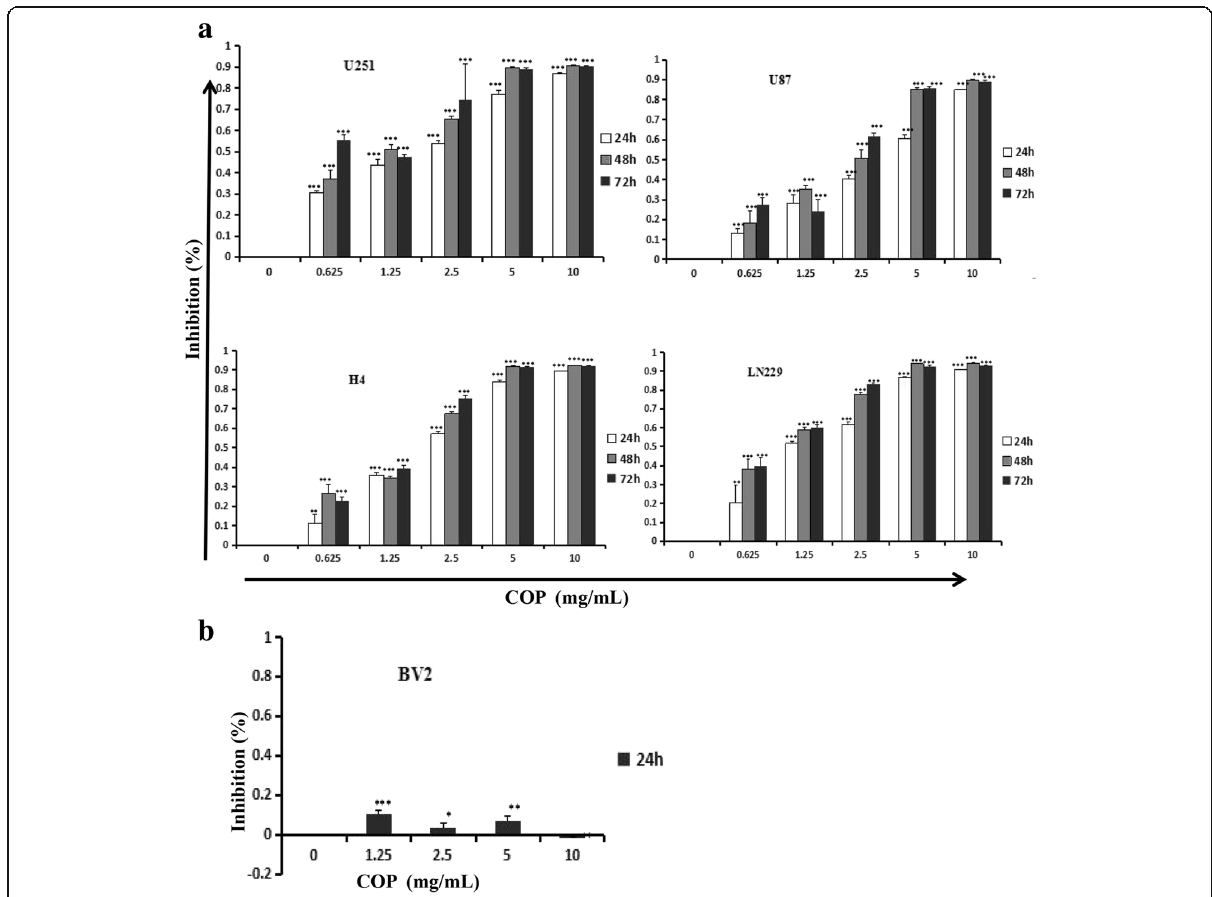
Fig. 2 U251, U87, H4 and LN229 ( a ) were treated with COP (0, 0.625, 1.25, 2.5, 5 and 10 mg/ml) for 24, 48 and 72 h, respectively; BV2 ( b ) cells as a control cell were treated with COP (0, 1.25, 2.5, 5 and 10 mg/ml) for 24 h; cell viability was analyzed by the MTT assay. All values represent the mean ± SD from 3 independent experiments. *, P < 0.05; **, P < 0.01; ***, P < 0.001 compared with the control